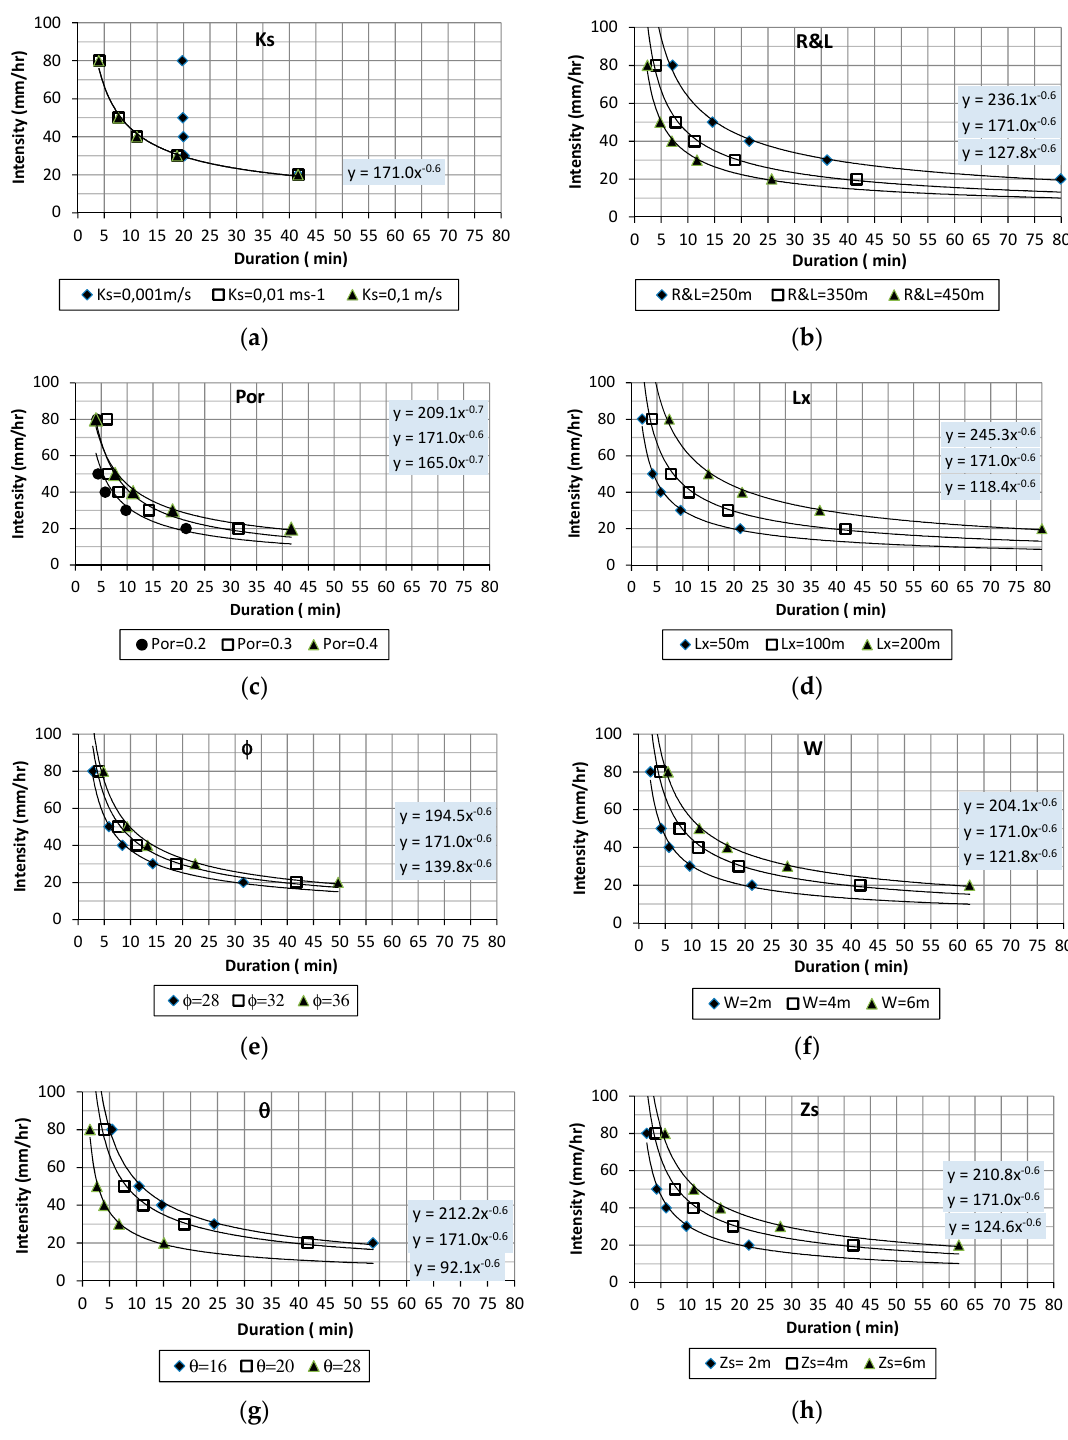
Figure 11. I-D curves for debris flow initiation by bed failure in relation to different geometrical and hydro-mechanical parameters. The regression formula belong to the curves from top to bottom. For the definition of parameters see Table 3.